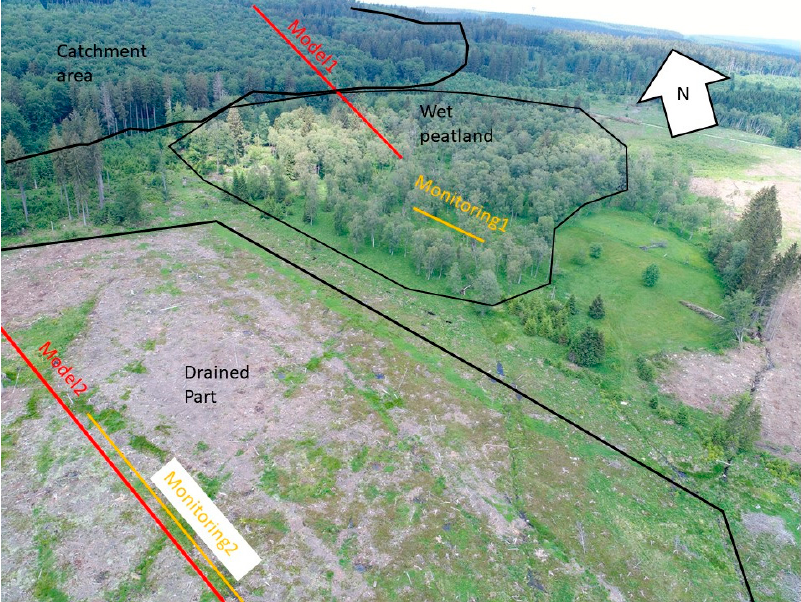
Figure 3. Aerial photograph of "Thranenbruch" taken from a drone (1 June 2008).